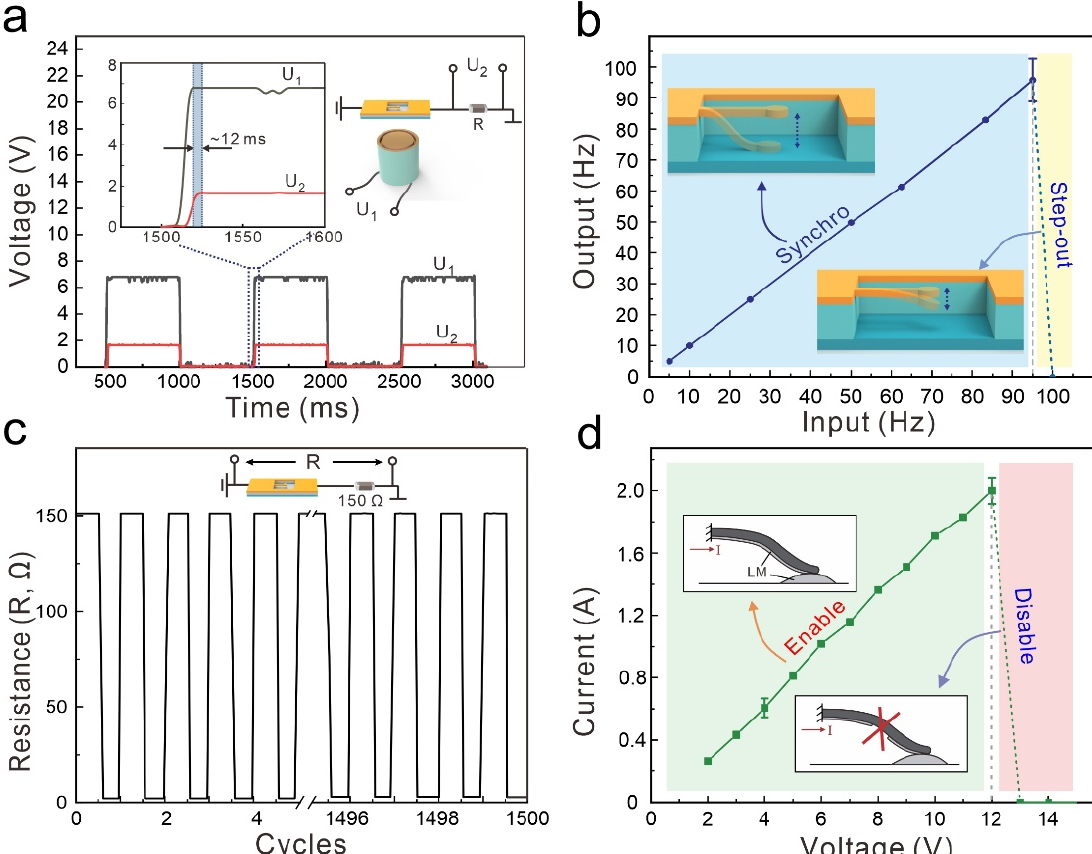
Figure 4. Electrical characteristics of MCSM. ( a ) The voltage on the electromagnet (U 1 ) and the constant resistance (U 2 ) at different times. ( b ) Connection frequency of a soft microswitch under different actuation frequencies. ( c ) Measured resistance (R) of the circuit during 1500 times cycling. ( d ) Loaded current of the microswitch under different voltages.